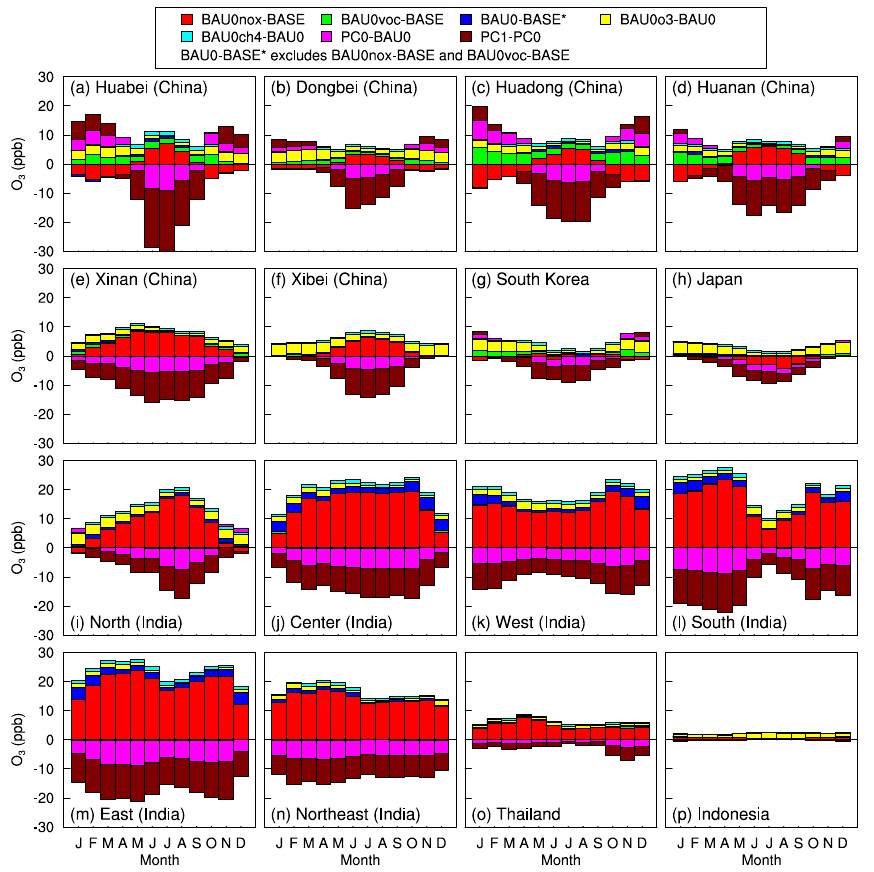
Figure 13. Differences in simulated monthly mean surface ozone concentrations among cases which are averaged over regions in China and India as well as Japan, South Korea, Thailand, and Indonesia.